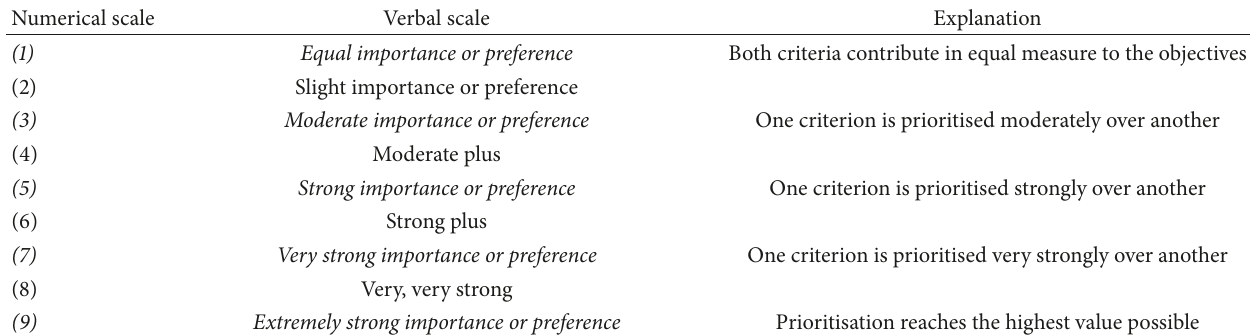
Table 2: Saaty fundamental scale [11,